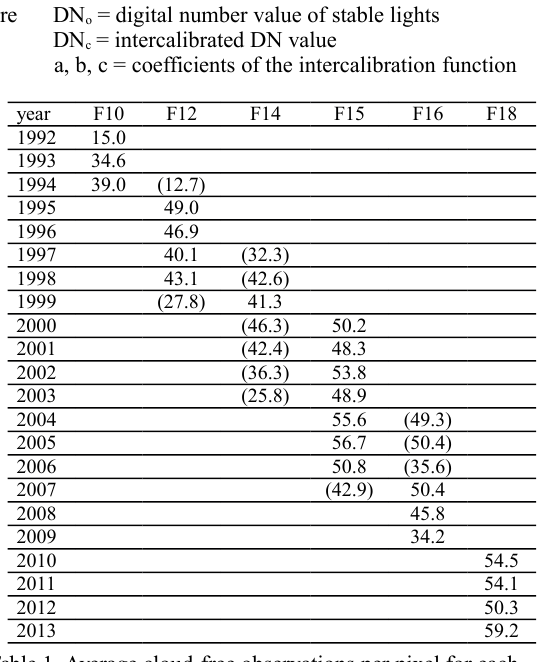
Table 1. Average cloud-free observations per pixel for each satellite year of stable lights. Discarded data in